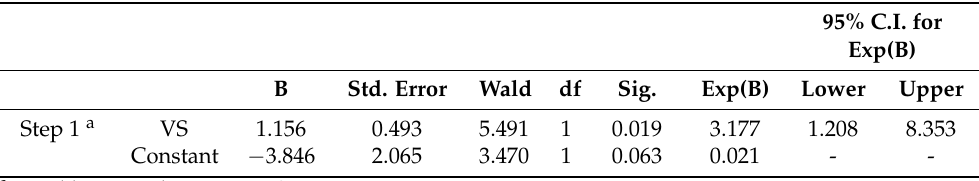
Table 28. Vendor support: regression analysis for